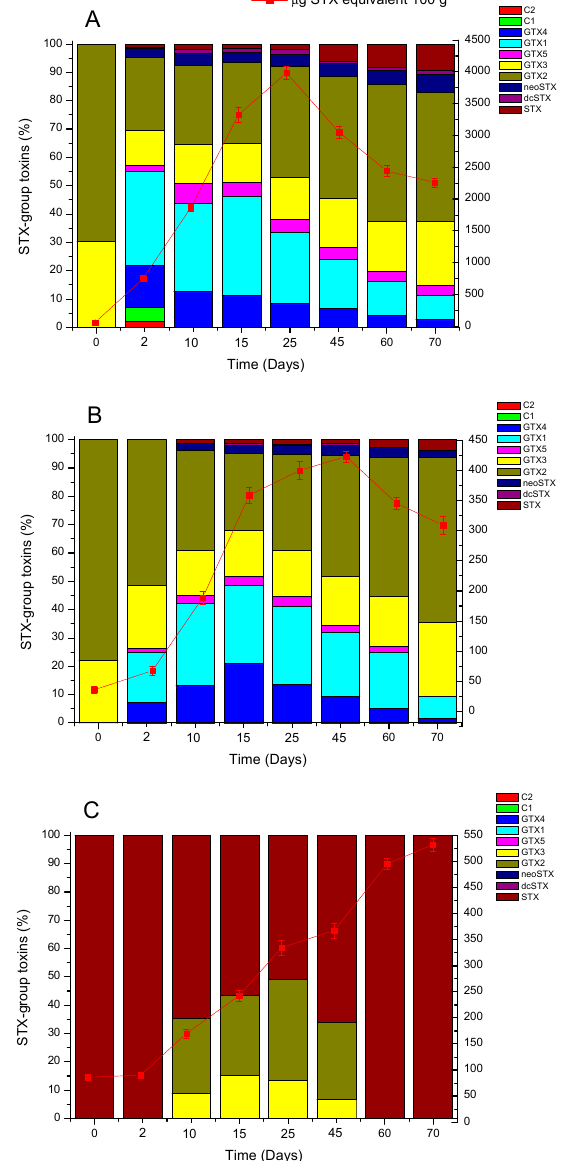
Figure 4. Total STX-group toxicity ( µ g STX equivalent 100 g − 1 ) and changes in the toxin profile (%) in digestive glands of ( A ) mussels ( Mytilus chilensis ), ( B ) clams ( Ameghinomya antiqua ), and ( C ) feet of locos ( Concholepas concholepas ) during a bloom of Alexandrium pacificum . Data are presented as the mean ± standard deviation (SD). ( n = 5).